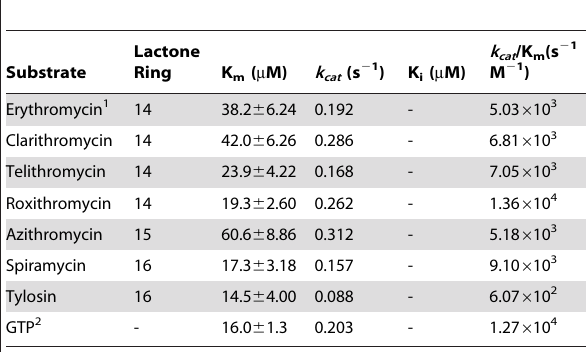
Table 4. Kinetic parameters for MPH (2 9 )-II from B. faecium DSM